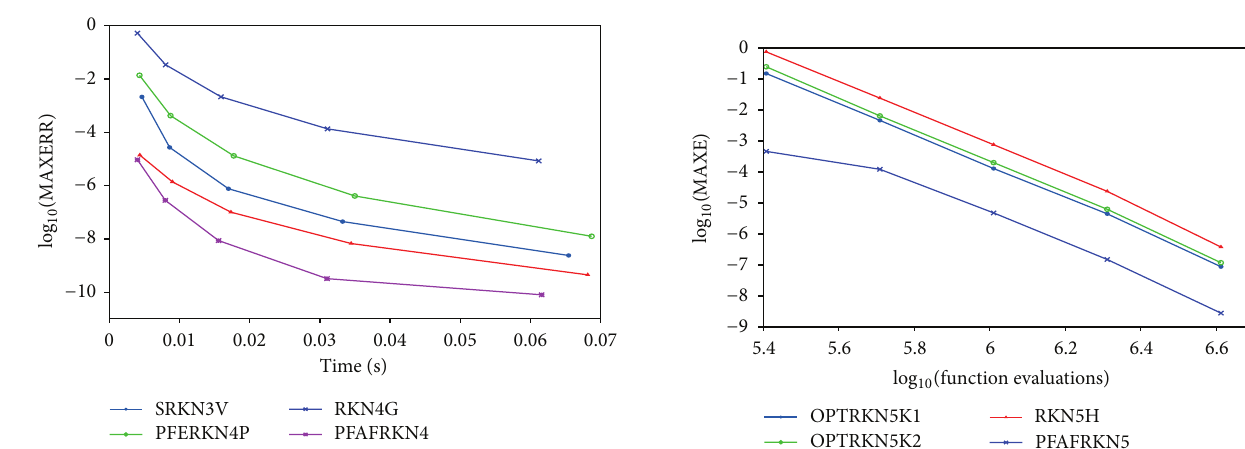
Figure 6: Efficiency curves for all methods for Problem 3 with ℎ = 1/2 𝑖 , 𝑖 = 4, ...,8 .